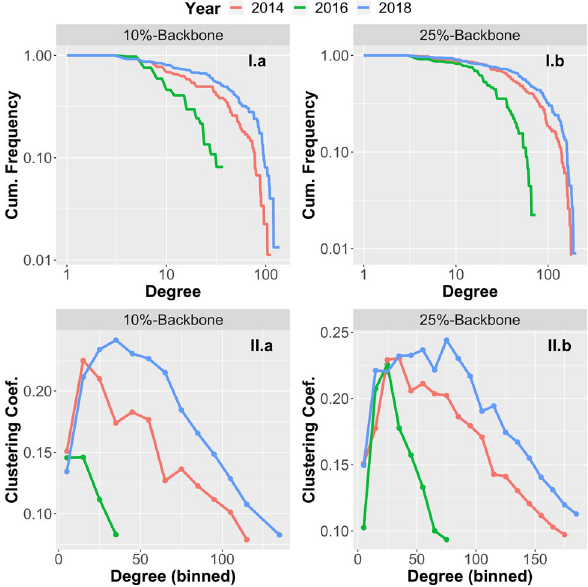
Figure 2. Degree distribution ( I ) and local clustering coefficients ( II ) in the 10%-backbone ( a ) and the 25%-backbone ( b ) of the EBA financial networks of 2014, 2016 and 2018.